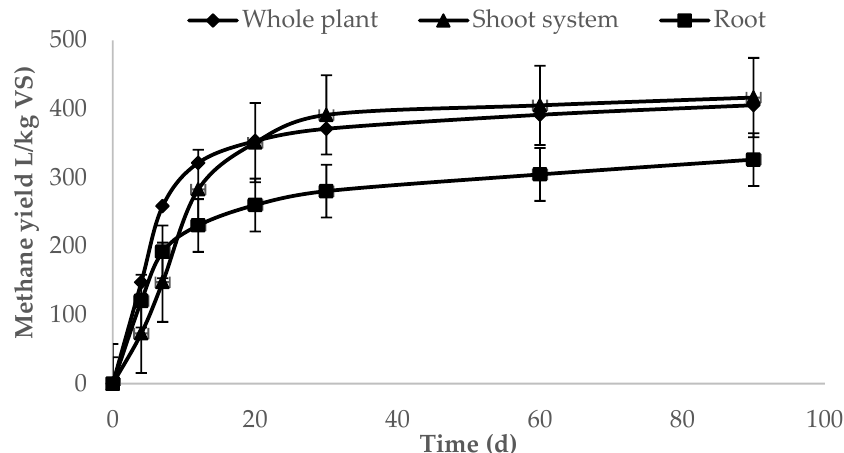
Figure 1. Methane production different part of Pistia stratiotes . Table 4. Methane yields different part of Pistia stratiotes. Cumulative Methane